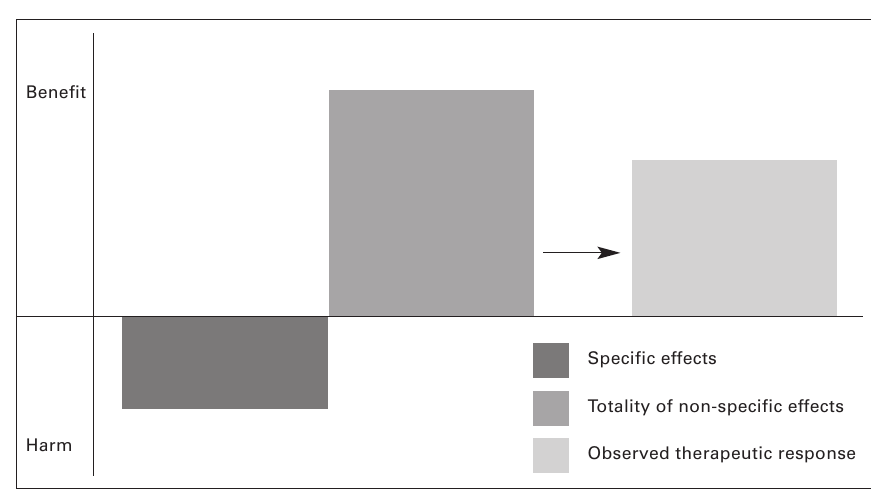
Schematic depiction of a positive therapeutic response after a treatment with harmful specific effects.